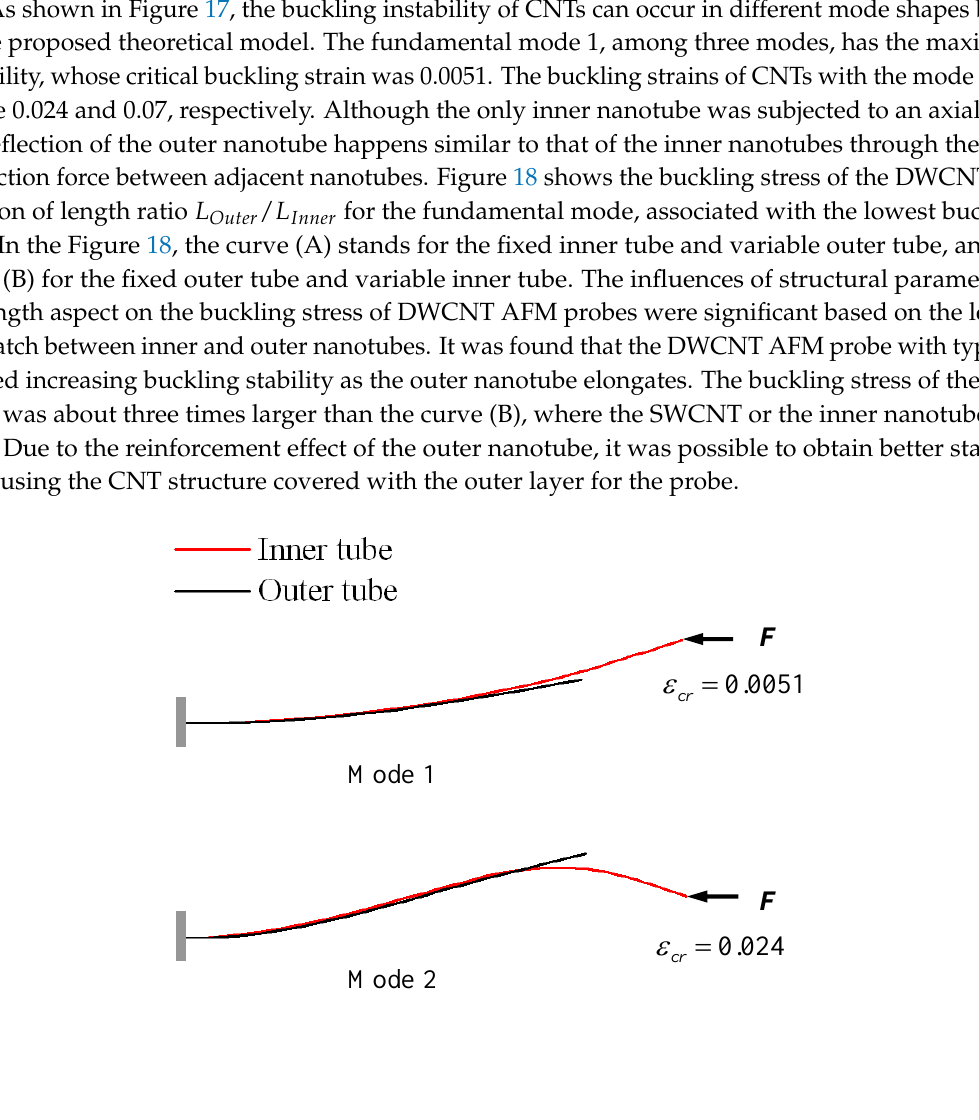
Figure 17. Schematic diagram describing the buckling instability of cantilevered ( 16,0 ) @ ( 26,0 ) DWCNTs, with the inner tube of 20 nm and the length ratio of outer to inner tubes of 20. Adapted with permission from [77], Copyright Elsevier, 2011.